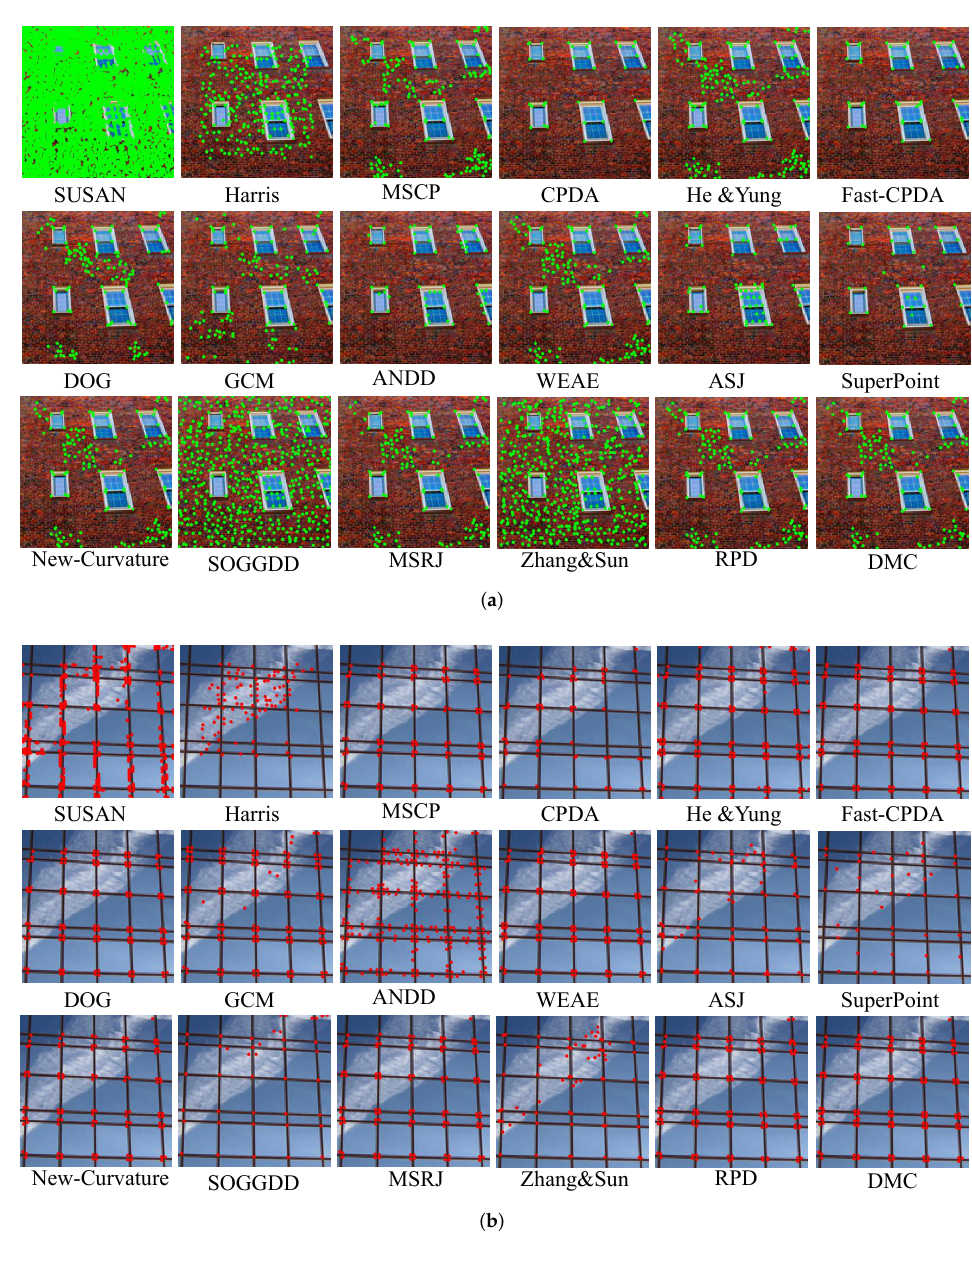
Figure 6. Subjective evaluation results for test images. ( a ) Test image 1. ( b ) Test image